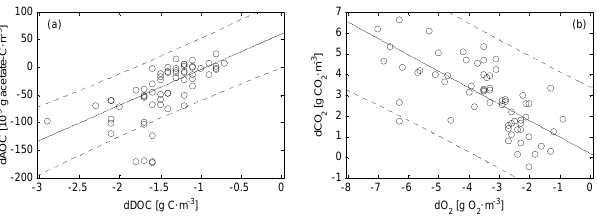
Figure 3. Linear regressions plus 95% confidence intervals for data from all 4 (B)GAC filters: ∆ AOC = 64 × 10 − 3 ∆ DOC + 60 × 10 −